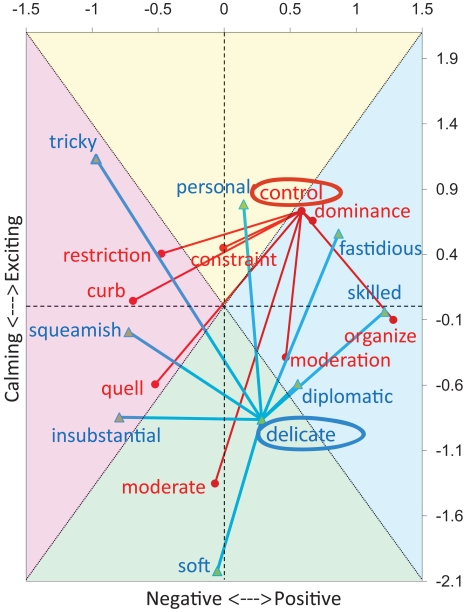
Semantics of the cognitive map (MS English): examples of connotation mapping.For each of the two representative (bold and circled) words, control and delicate, 8 synonyms are selected such that they nearly uniformly occupy all quadrants.